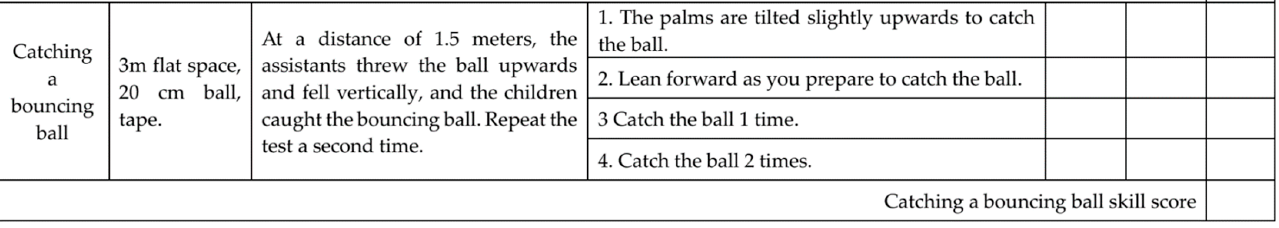
Figure 2. Catching a bouncing ball test score